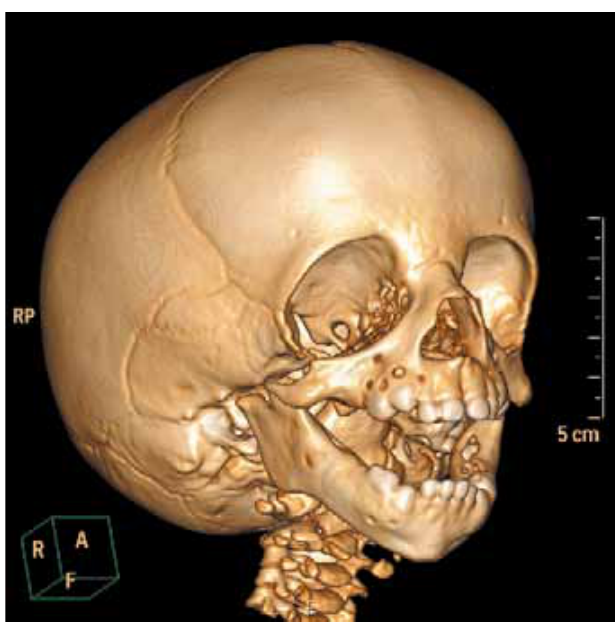
Fig. 2. An 11-month-old girl. The 3D image demonstrates the hypoplastic zygomas and mandibilar ramus. The orbits are